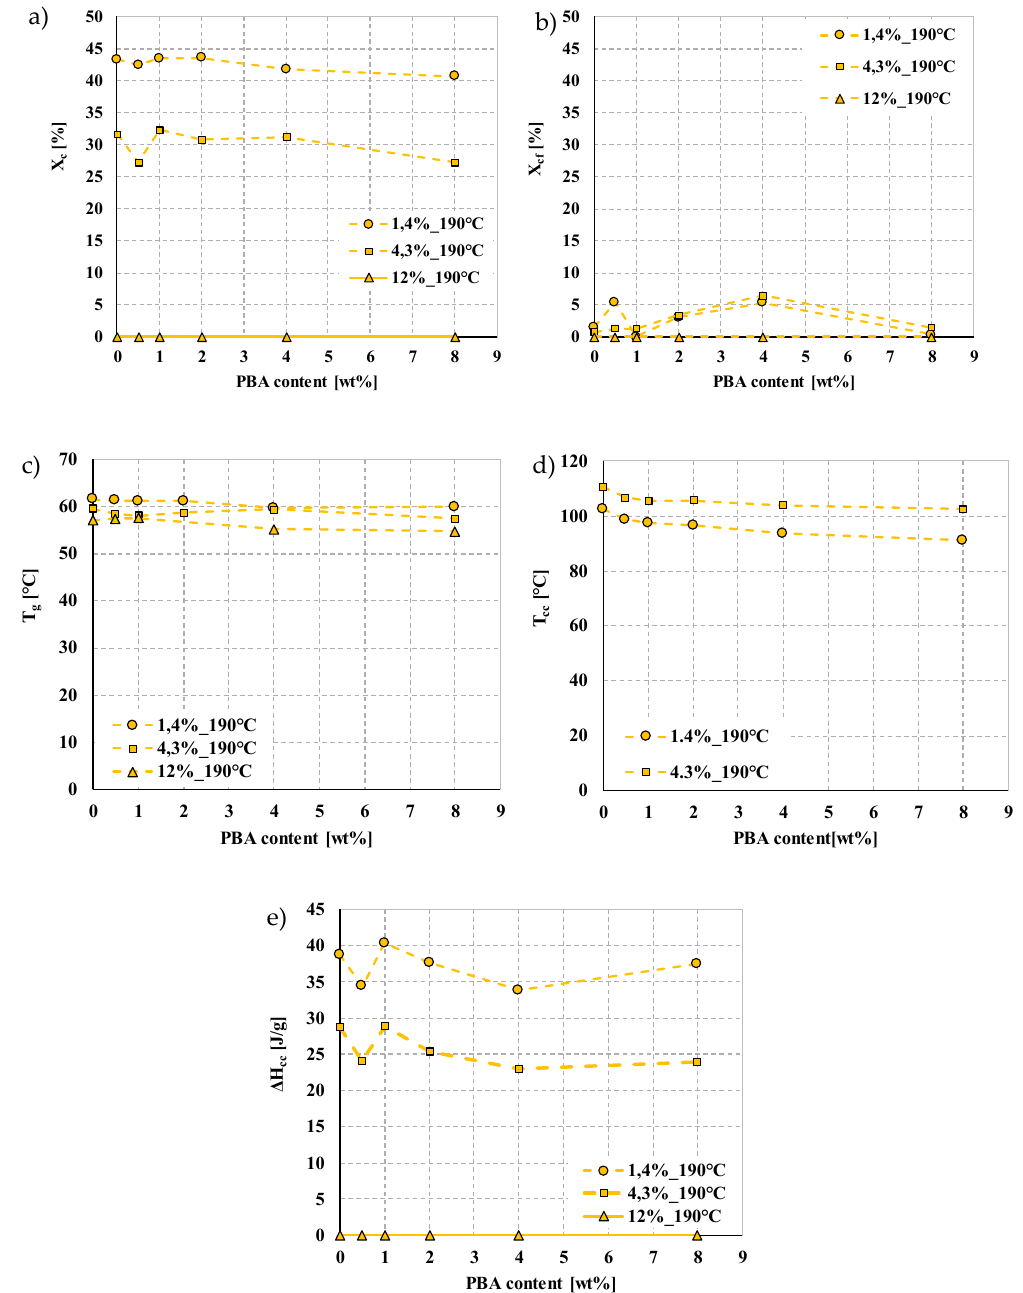
Figure 10. DSC (1st heating) results of foams produced from three types of PLAs with different d -lactide contents ( a ) crystalline fraction, ( b ) crystalline fraction during processing, ( c ) glass transition temperature, ( d ) cold crystallization temperature, ( e ) cold crystallization enthalpy at a processing temperature of 190 °C.